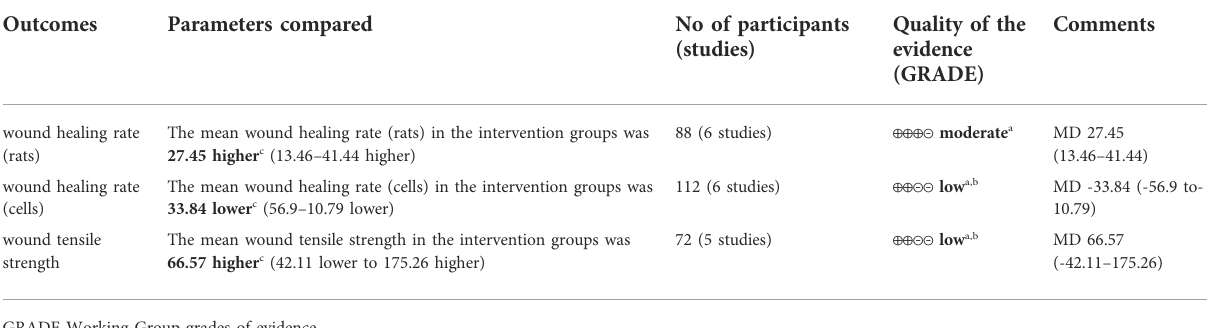
TABLE 3 Summary of fi ndings table as per GRADE working